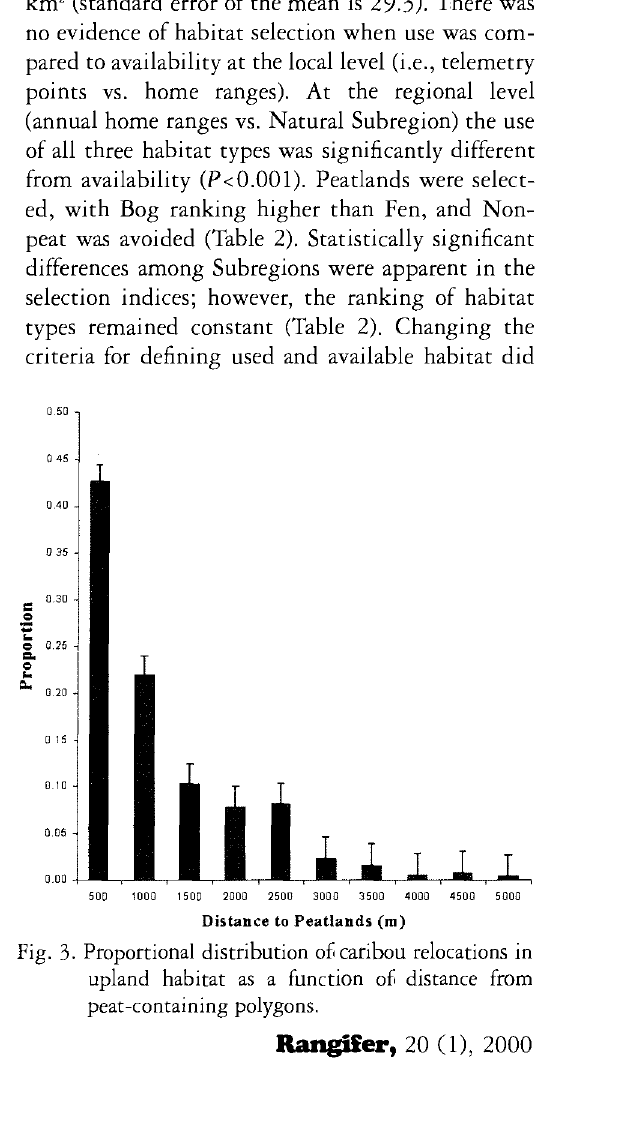
Fig. 3. Proportional distribution of caribou relocations in upland habitat as a function of distance from peat-containing